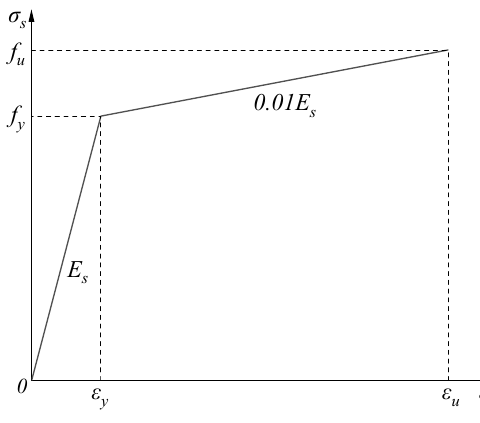
Figure 5. Constitutive relation of steel bar. Table 3. Material properties of steel bar.